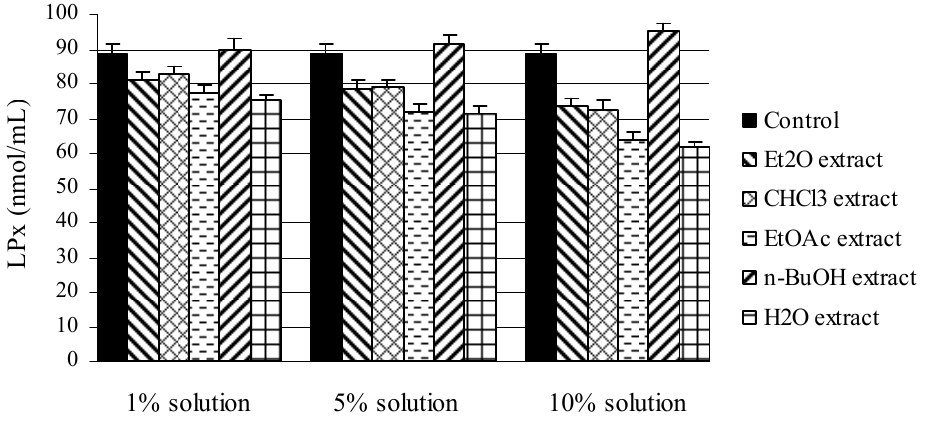
Figure 2. Inhibition of LP in Fe 2+ /ascorbate system of induction by different extracts of M. melissophyllum in the TBA